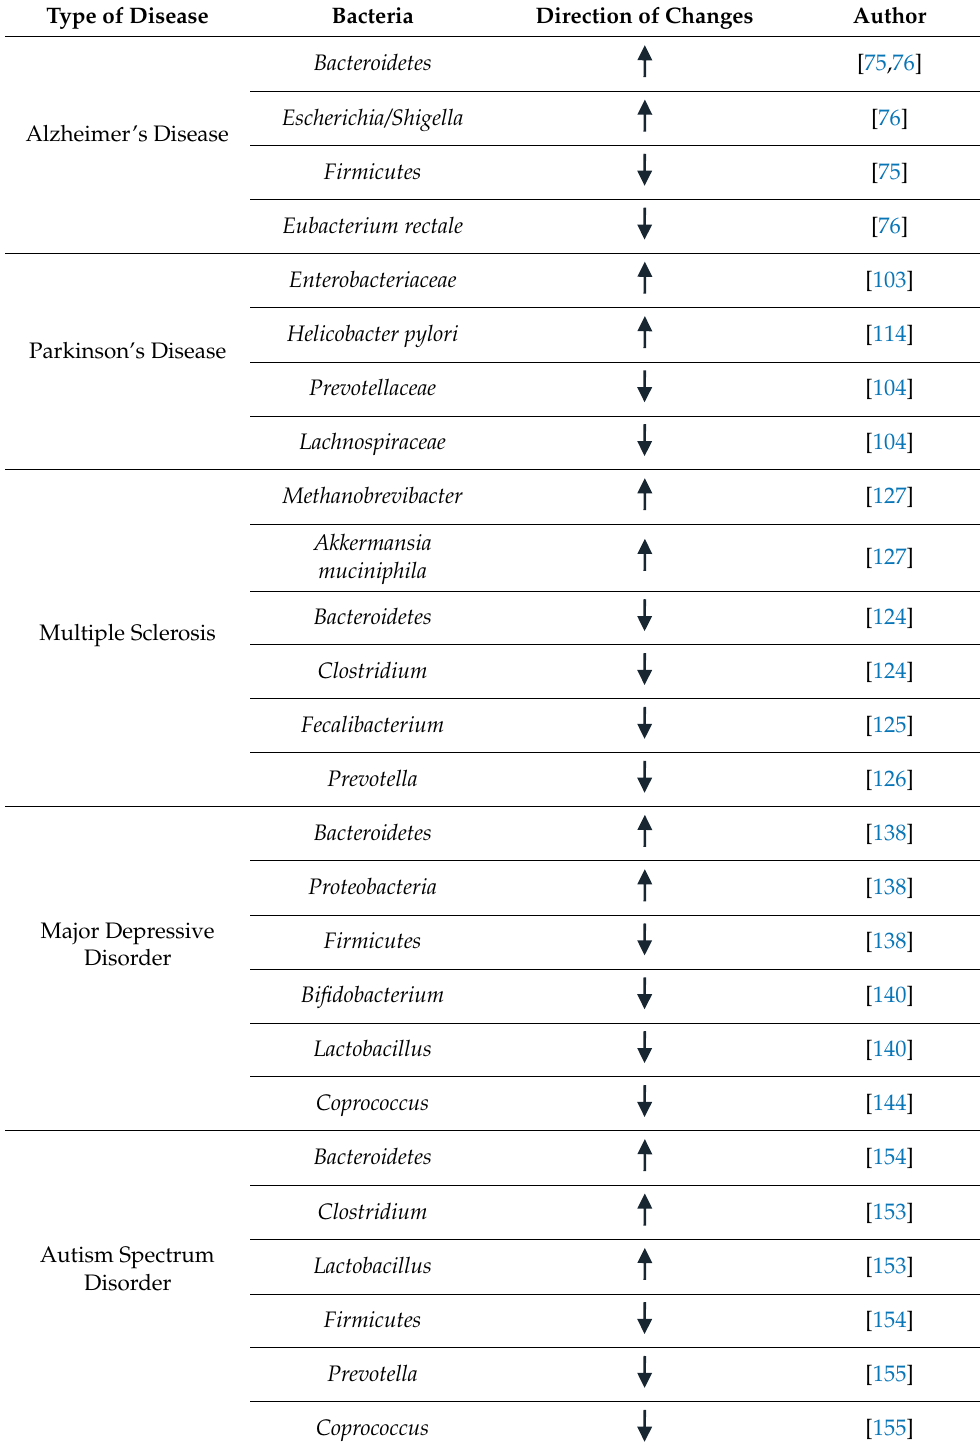
Table 1. Changes in the microbiota in neurological diseases.